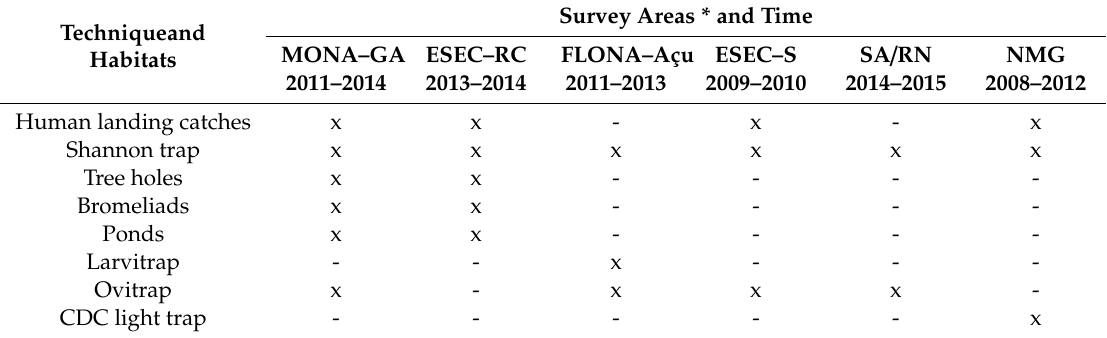
Table 1. Set of collection techniques applied and habitats searched in surveys conducted in the Caatinga biome between 2008 and